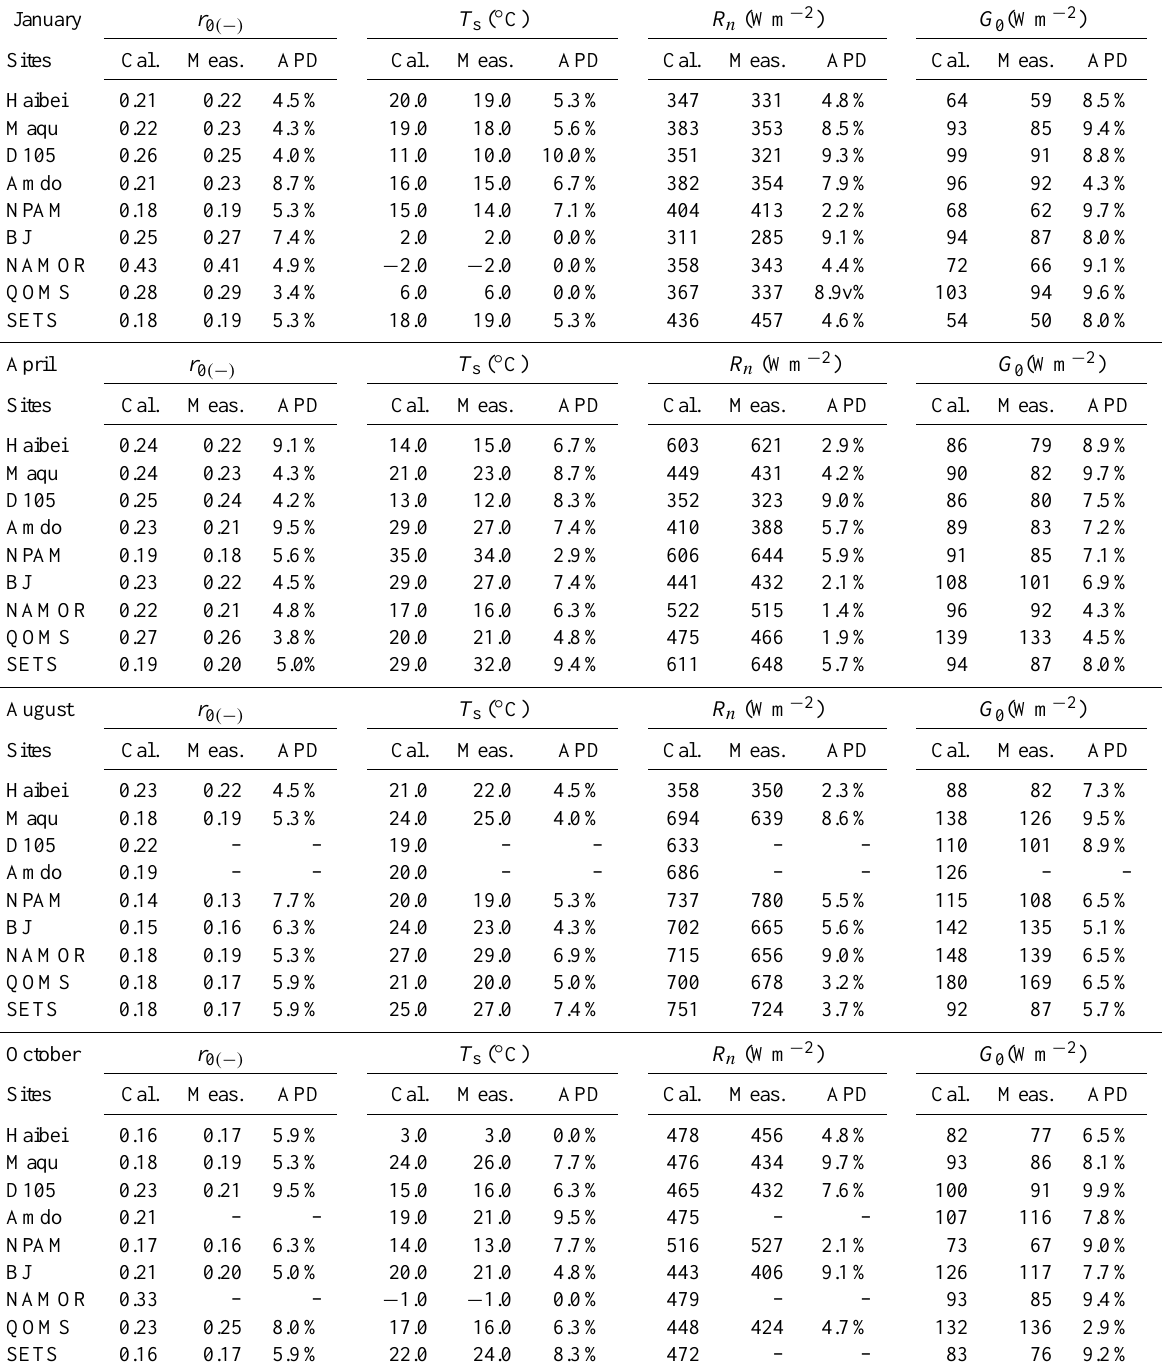
Table 1. Comparison of the derived surface reflectance, surface temperature, net radiation flux and soil heat flux(Cal.) versus the values measured (Meas.) at the Tibetan Plateau with absolute percent difference (APD).